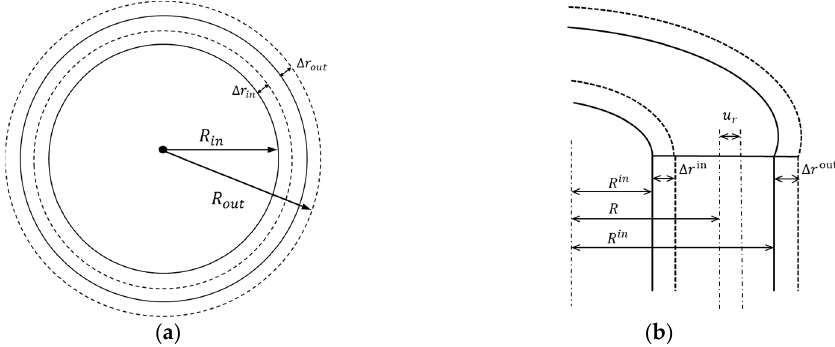
Figure 4. Radial displacement and deformation of pipe layer: ( a ) vertical view; ( b ) profile view.